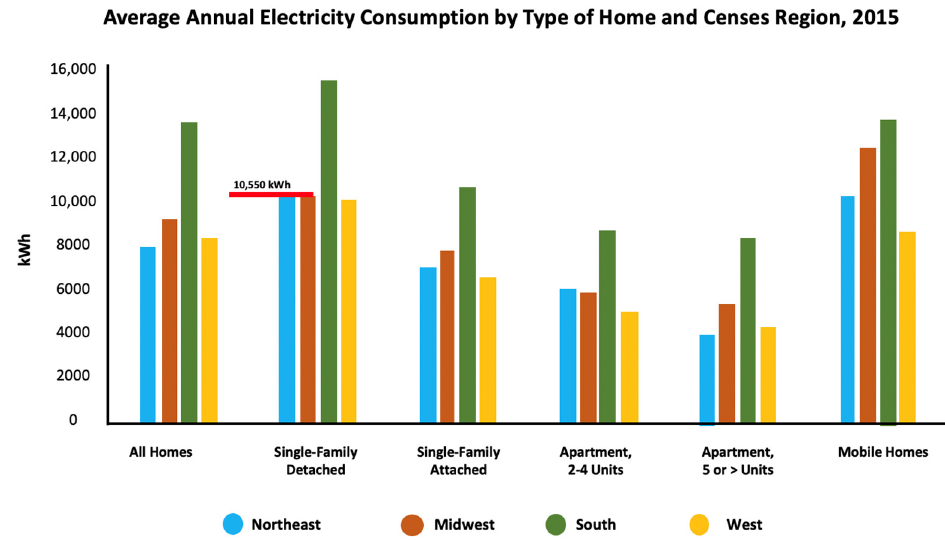
Figure 5. Annual average electric consumption by single household home in rural USA.